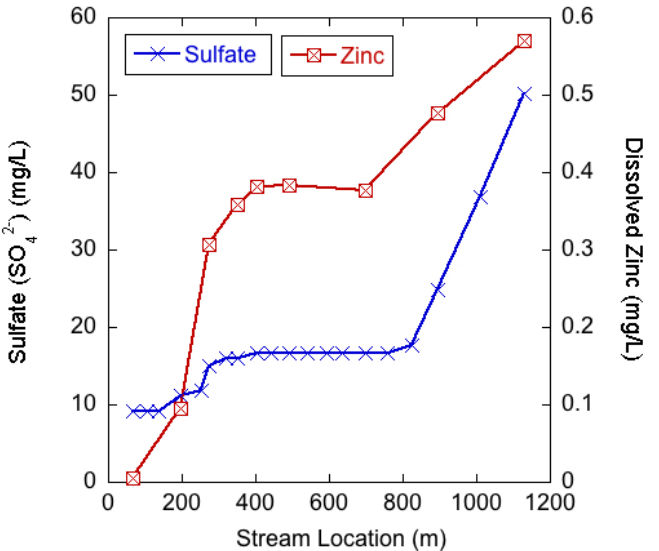
Figure 4. Sulfate and dissolved zinc concentrations in Silver Creek from synoptic sampling during base flow conditions on 7 October 2011. Stream locations are in m downstream from the location of the stream tracer injections with the stream crossing the mine workings at approximately 400 m. There are known inflows to Silver Creek from seepage below the mine tailings entering between SC-895 and SC-1131 in Figure